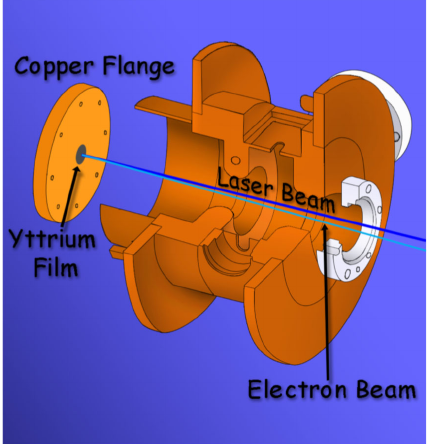
FIG. 4. Drawing of the section of rf gun. The blue line is the laser trajectory, whereas the light blue line is the electron beam.